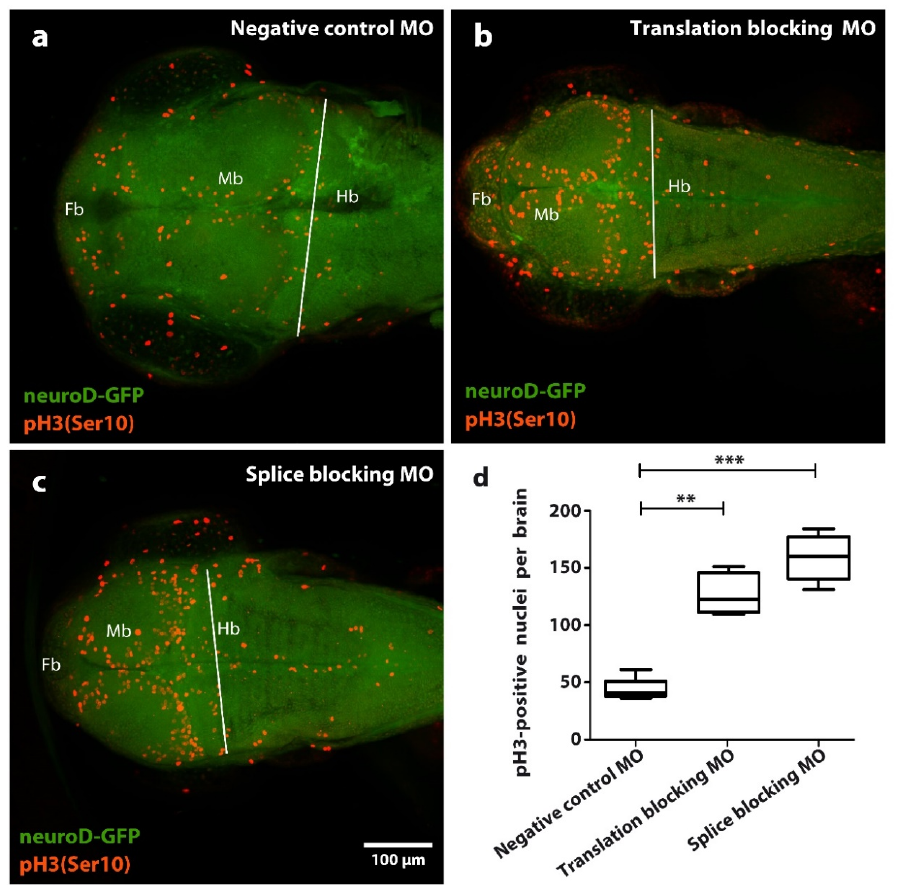
Figure 3. Effect of tubgcp2 knockdown using microinjection of morpholino antisense oligonucleotides (MOs) blocking either splicing or translation, on number of pH3/Ser10) immunoreactive (IR) nuclei in zebrafish brain tissue at 3 dpf. Immunohistochemical staining of Tg(neuroD:GFP) larvae 2 dpf (green): pH3 (Ser 10) (red) shows distribution of pH3 (Ser 10) IR nuclei in ( a ) control, ( b ) translation- blocking MO, and ( c ) splice-blocking MO-treated groups within the forebrain (Fb), midbrain (Mb), and hindbrain (Hb). ( d ) Quantification of pH3 (Ser 10) IR nuclei in larvae at 2 dpf.